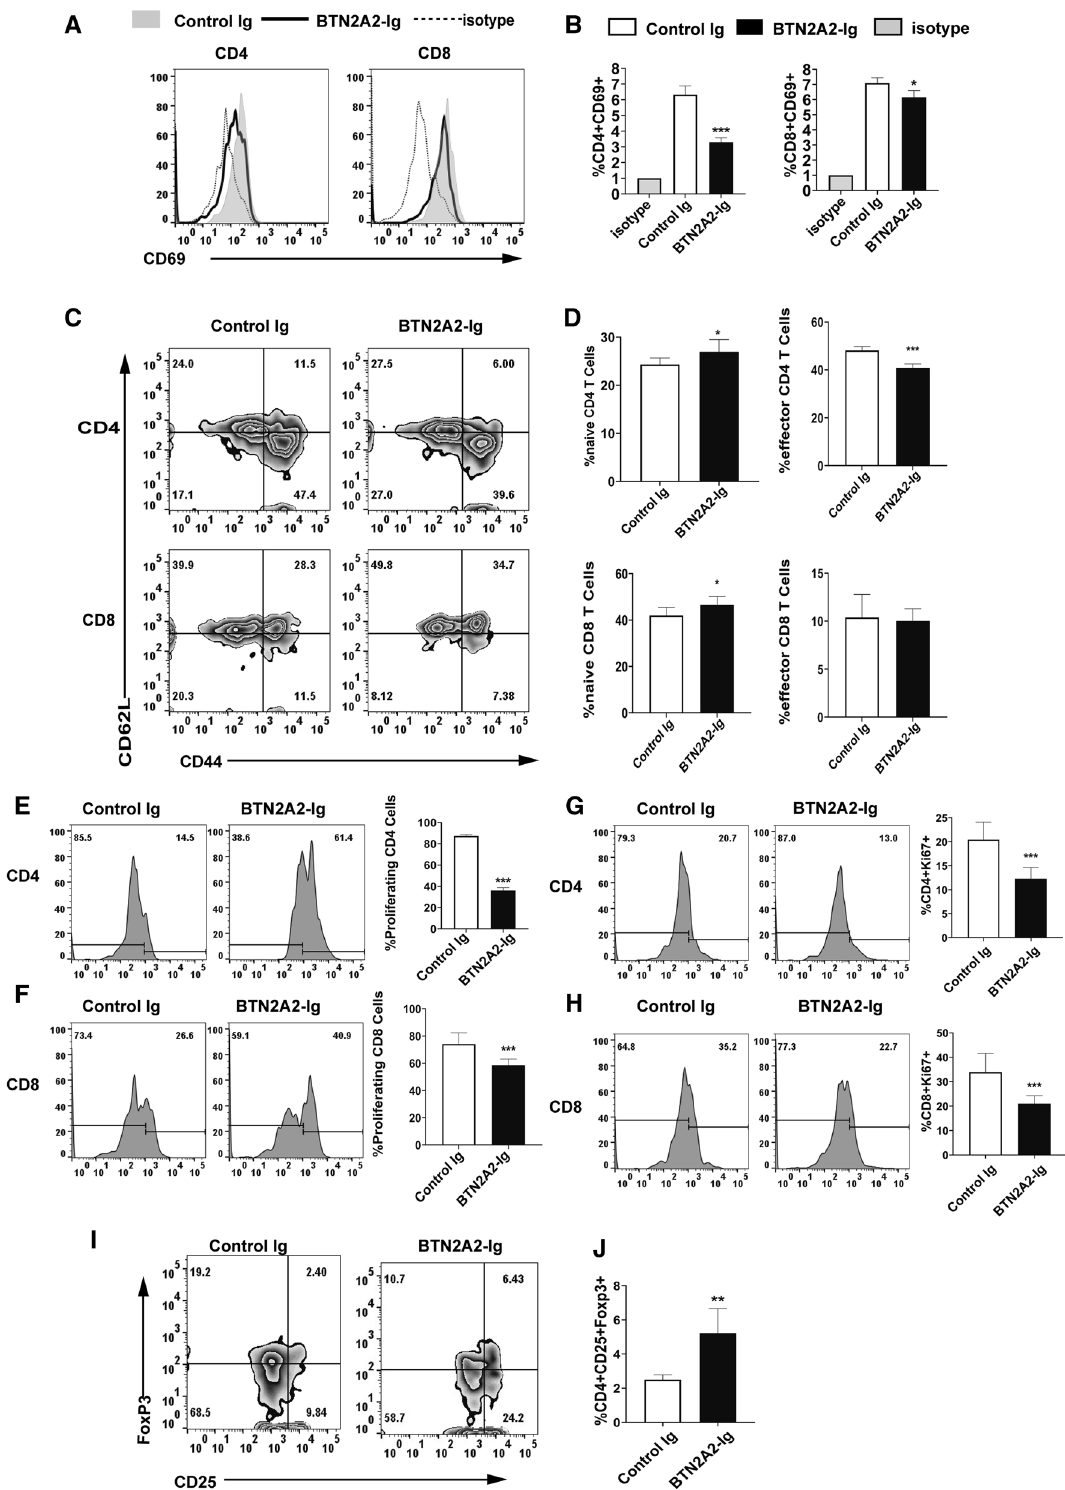
Figure 5. BTN2A2-Ig inhibits T cell activation and proliferation in CIA mice. DBA/1J CIA mice were treated with BTN2A2-Ig or control Ig as in Fig. 4. The spleens were harvested 35 days later. Spleen cells were stained with anti-CD69 or isotype antibodies as well as anti-CD4, CD8 antibody to identify activated cells. The splenocytes were analyzed for ( A , B ) the expression of CD69 by CD4 and CD8 T cells, ( C , D ) the percentages of CD44 lo CD62L hi naïve and CD44 hi CD62L lo effector memory in CD4 and CD8 T cells, and T cell proliferation by ( E , F ) CFSE dilution assay and ( G , H ) Ki67 staining. ( I , J ) The splenocytes were also analyzed for the percentages of CD25 + FoxP3 + CD4 + Tregs. The data are expressed as the mean ± SD and representative of three independent experiments with similar results. (n = 6 each experiment each group) * P < 0.05, *** P < 0.001 compared with